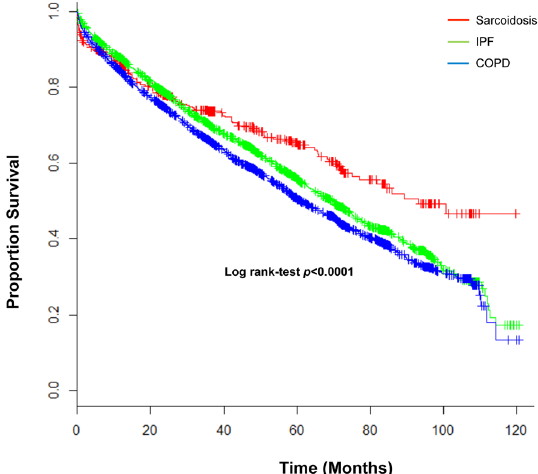
Figure 1. Kaplan Meier curves displaying survival rates between Sarcoidosis, COPD and IPF groups.